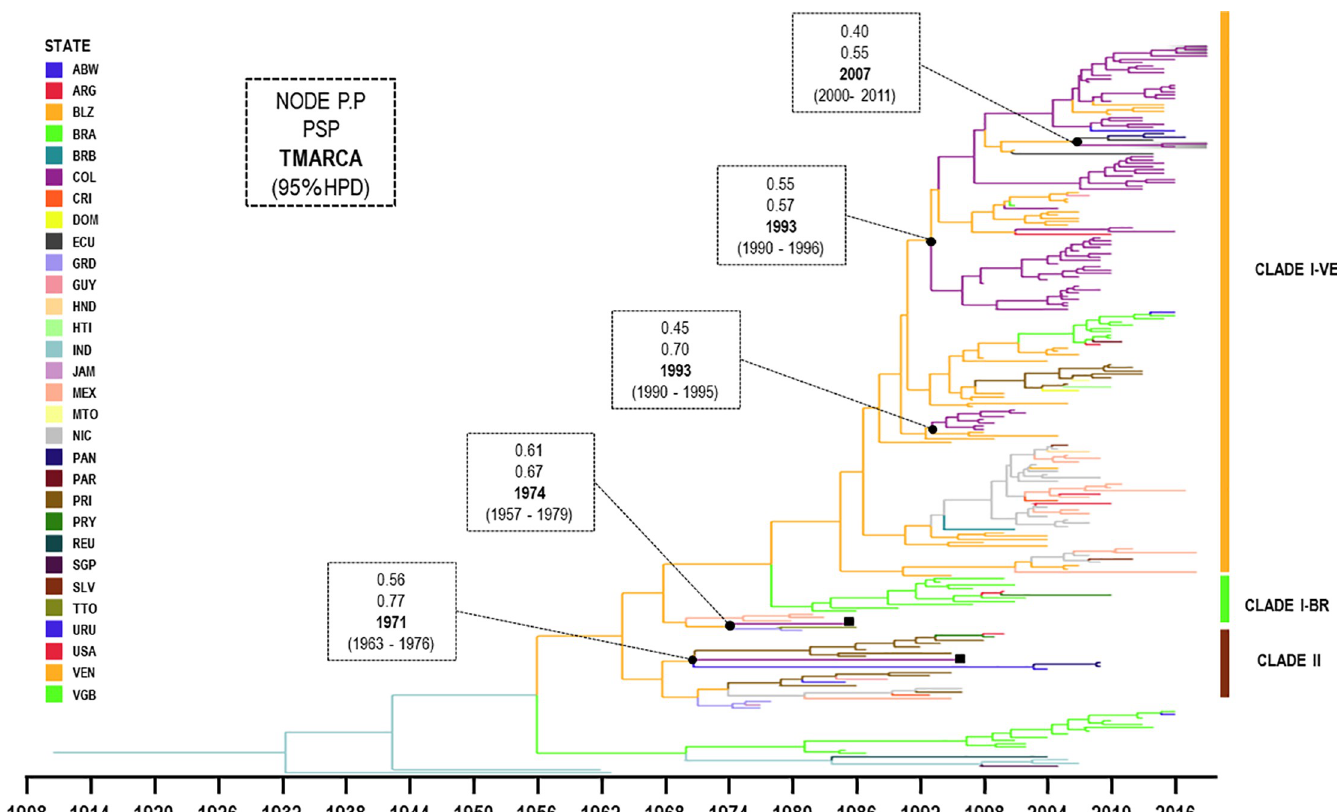
Fig 4. Maximum clade credibility tree of DENV-1 corresponding to the genotype V. Branches are coloured according to the most probable location of their parental node and legends shown on the left side. All horizontal branch lengths are drawn according to a scale of years. Two clades (I-II) and subclade of the clade I (VE: Venezuela, BR: Brazil) are identified on the right side and the gray frame represented our sequences isolated from Villa del Rosario, Norte de Santander. ■ : virus strains isolated in 1985 (AF425616) and 1996 (AF425617) available in Genbank. PSP: posterior state probability, PP: posterior probability, TMRCA: the mean estimated time to the most recent common ancestor and 95% HPD: 95% highest posterior density interval. ABW: Aruba, CRI: Costa Rica, ECU: Ecuador, GRD: Grenada, COL: Colombia, GUY: Guyana, NIC: Nicaragua, MTQ: Martinique, MEX: Mexico, URU: Uruguay, PRY: Paraguay, PRI: Puerto Rico, JAM: Jamaica, PER: Peru, BRA: Brazil, TTO: Trinidad and Tobago, HTI: Haiti, VGB: British Virgin Islands, VEN: Venezuela, IND: India, SGP:Singapure and REU:Reunion.